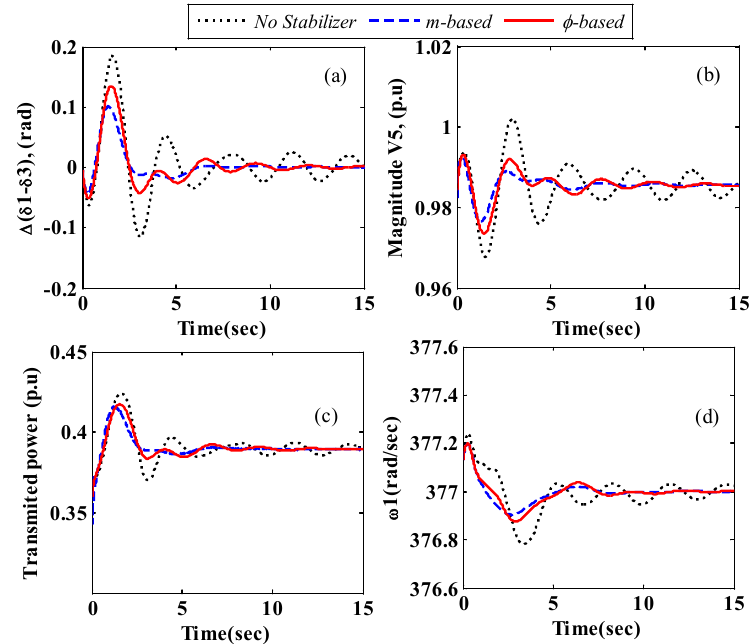
Figure 13. Nonlinear simulations in light loading using a robust-based stabilizer designed by the hGWO-GA algorithm (( a ) angle difference between G 1 and G 3 , ( b ) magnitude of voltage bus 5, and ( c ) transmitted power between area1 and area2, ( d ) rotor speed of generator G1).